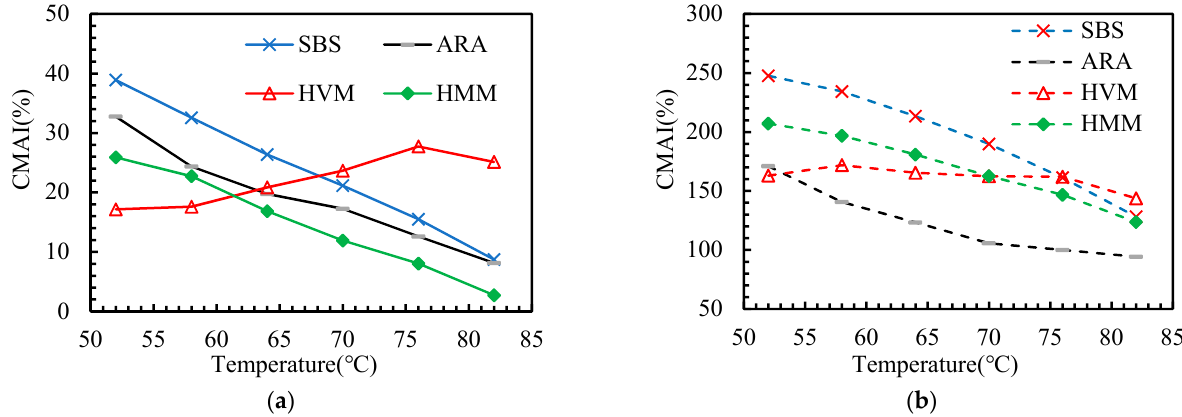
Figure 8. Complex Modulus Aging Indicator (CMAI) of the asphalt binders after aging: ( a ) TFOT; ( b ) PAV.